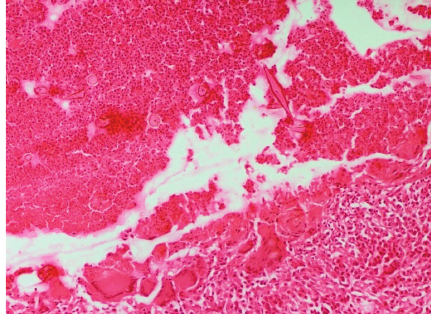
Figure 5: Higher magnification of previous figure showing inflam- matory rim and foreign body giant cells more clearly. H&E × 200.